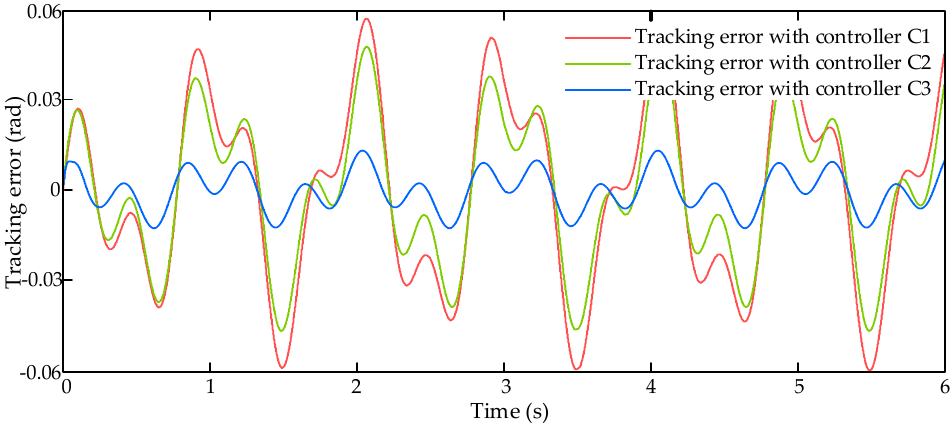
Figure 7. Tracking errors with dynamic signal input command.